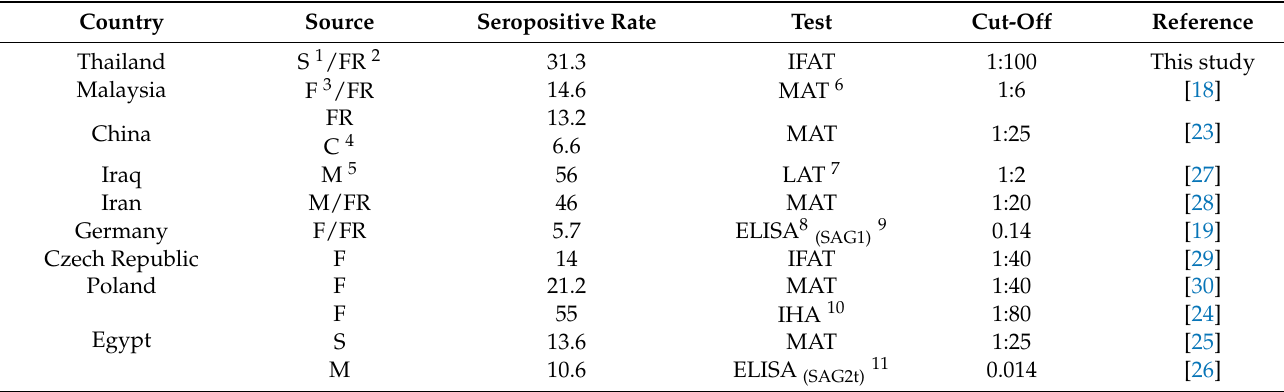
Table 2. Worldwide seropositive rates of T. gondii in